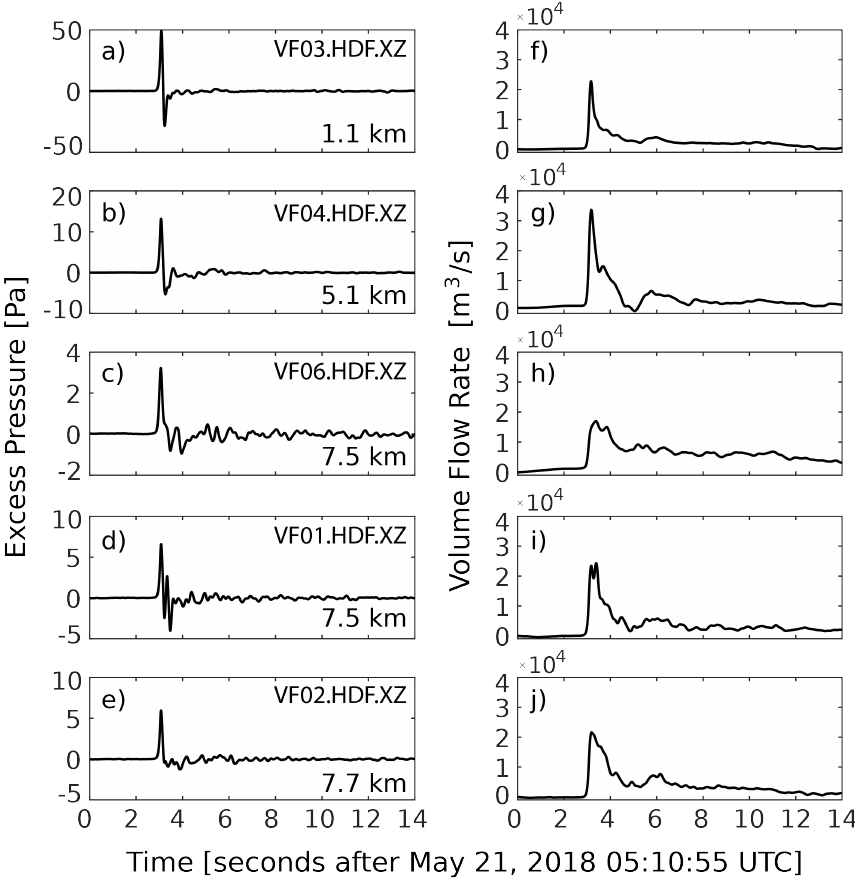
Figure 6. Volume flow source time functions derived from integration of infrasound waveforms at Fuego volcano, Guatemala: ( a – e ) explosion infrasound recorded at a range of distances from the source; and ( f – j ) time series of volume flow rate calculated from ( a – e ) according to Equation (10). The inconsistency of peak volume flow rate and variability in the shape of the volume flow rate source time functions suggest that: (i) the attenuation does not follow simple geometrical spreading